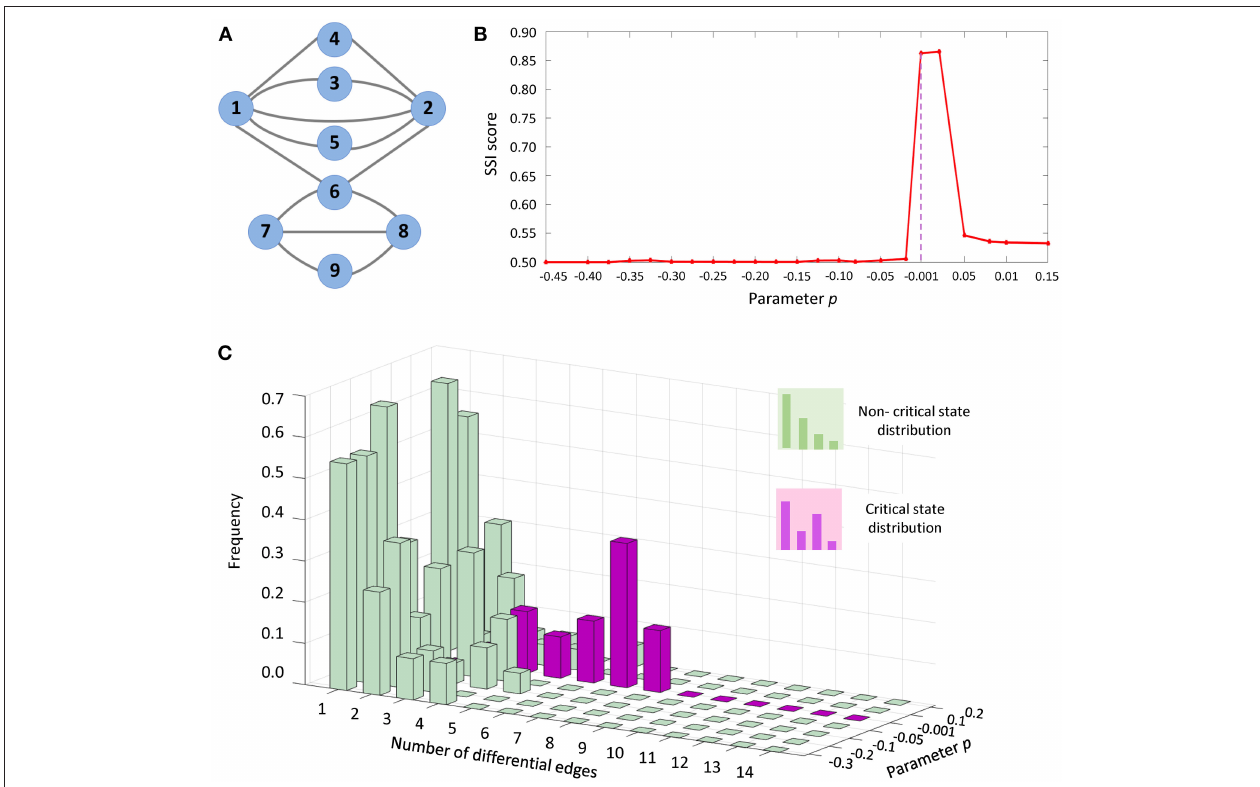
FIGURE 3 | The application of SSI score in numerical simulation. (A) The numerical simulation was based on a nine-node regulatory network. (B) The abrupt increase of SSI score indicates the tipping point at P = 0. (C) From the dynamical changes of differential-edge distribution, it is seen that there is a significantly different distribution (purple bars) comparing with others (green bars) when the system approaches the tipping point ( p = 0).